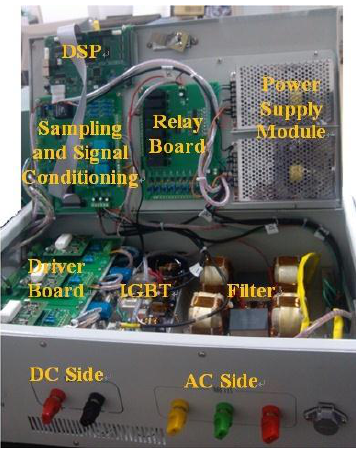
Figure 12. Laboratory setup to test the controller performance.